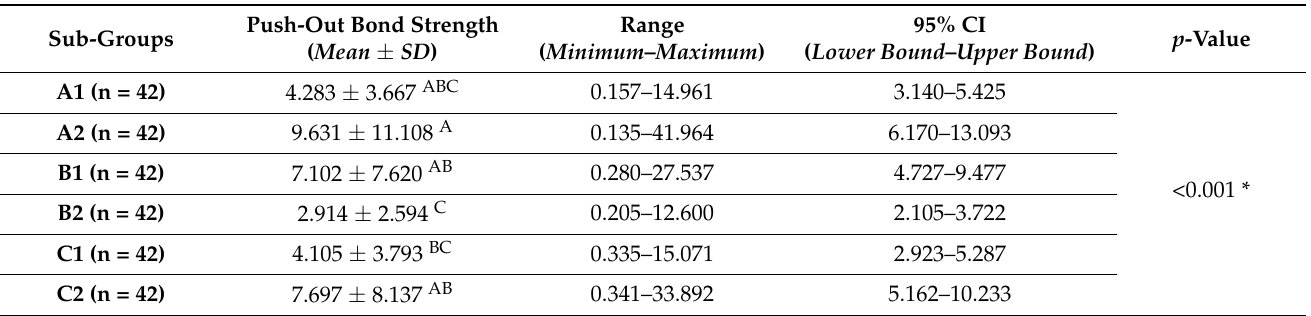
Table 1. Comparison of push-out bond strength means (in MPa) between sub-groups regardless of root levels (n = 252).